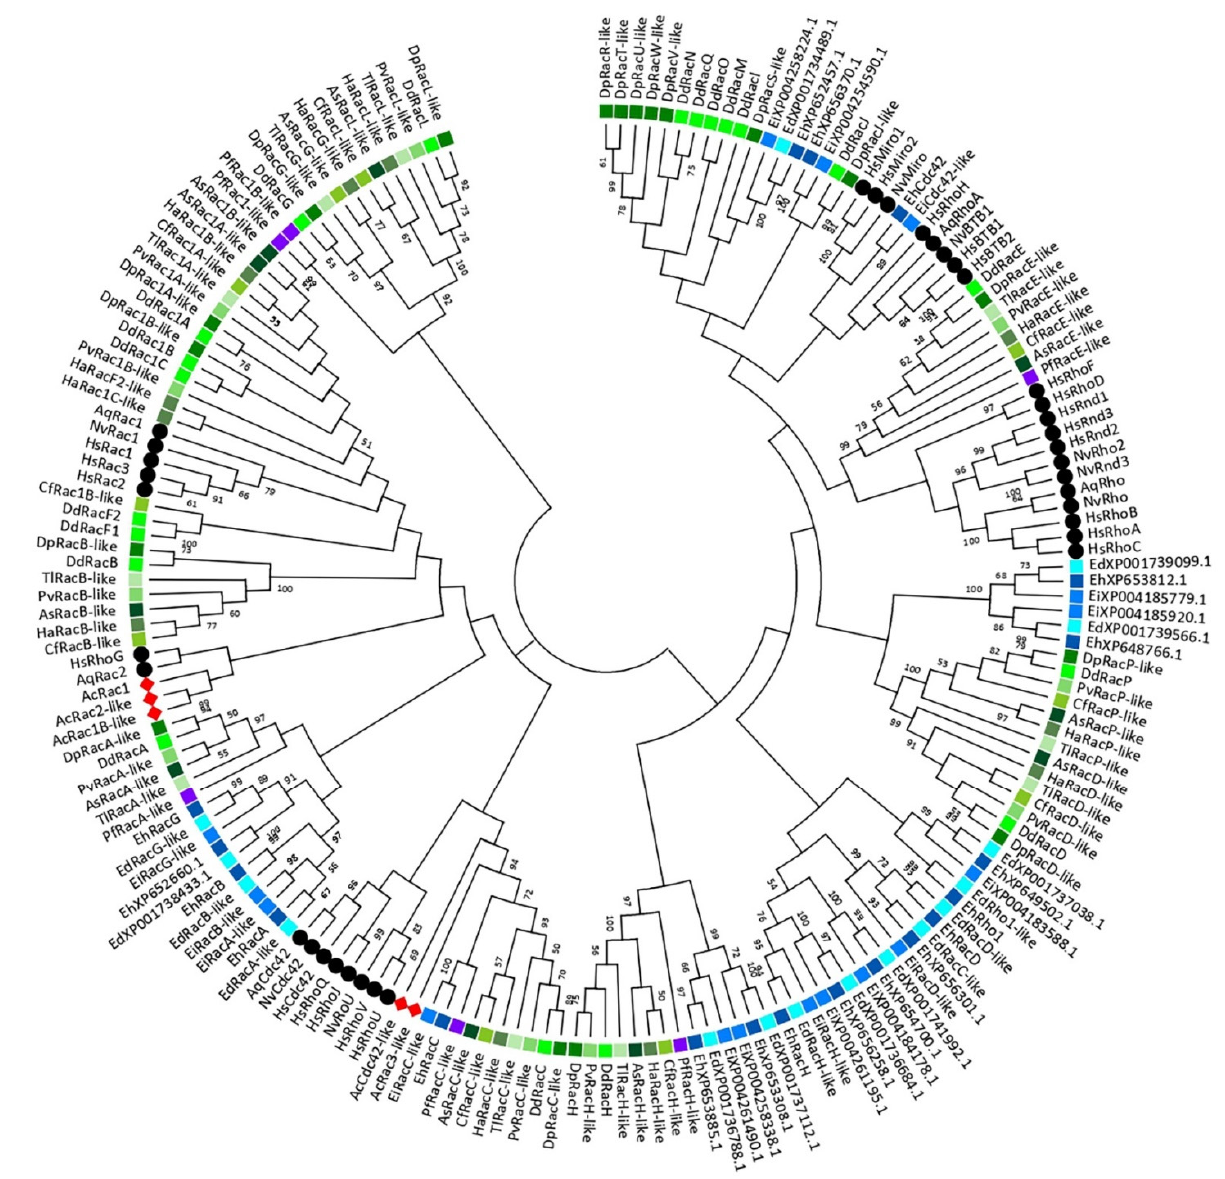
Figure 1. Phylogenetic tree of Rho GTPases in Amoebozoa. The evolutionary history was inferred using the maximum likelihood method and the Le_Gascuel_2008 model [36]. Evolutionary analyses were conducted in MEGAX [37], based on 186 amino acid sequences (accession numbers and sequences are presented in Supplementary File 2). Numbers at nodes are bootstrap percentages evaluated from 1000 bootstrapping replications (bootstrap values higher than 50 are indicated at the branching points). Rho GTPases from Metazoa are indicated by black circles. Amoebozoan Rho GTPases are marked as follows: subphylum Lobosa, class Discosea by red rhombus; subphylum Conosa, classes Archamoebea, Dictyostelia, and Variosea by blue, green, and purple squares, respectively.